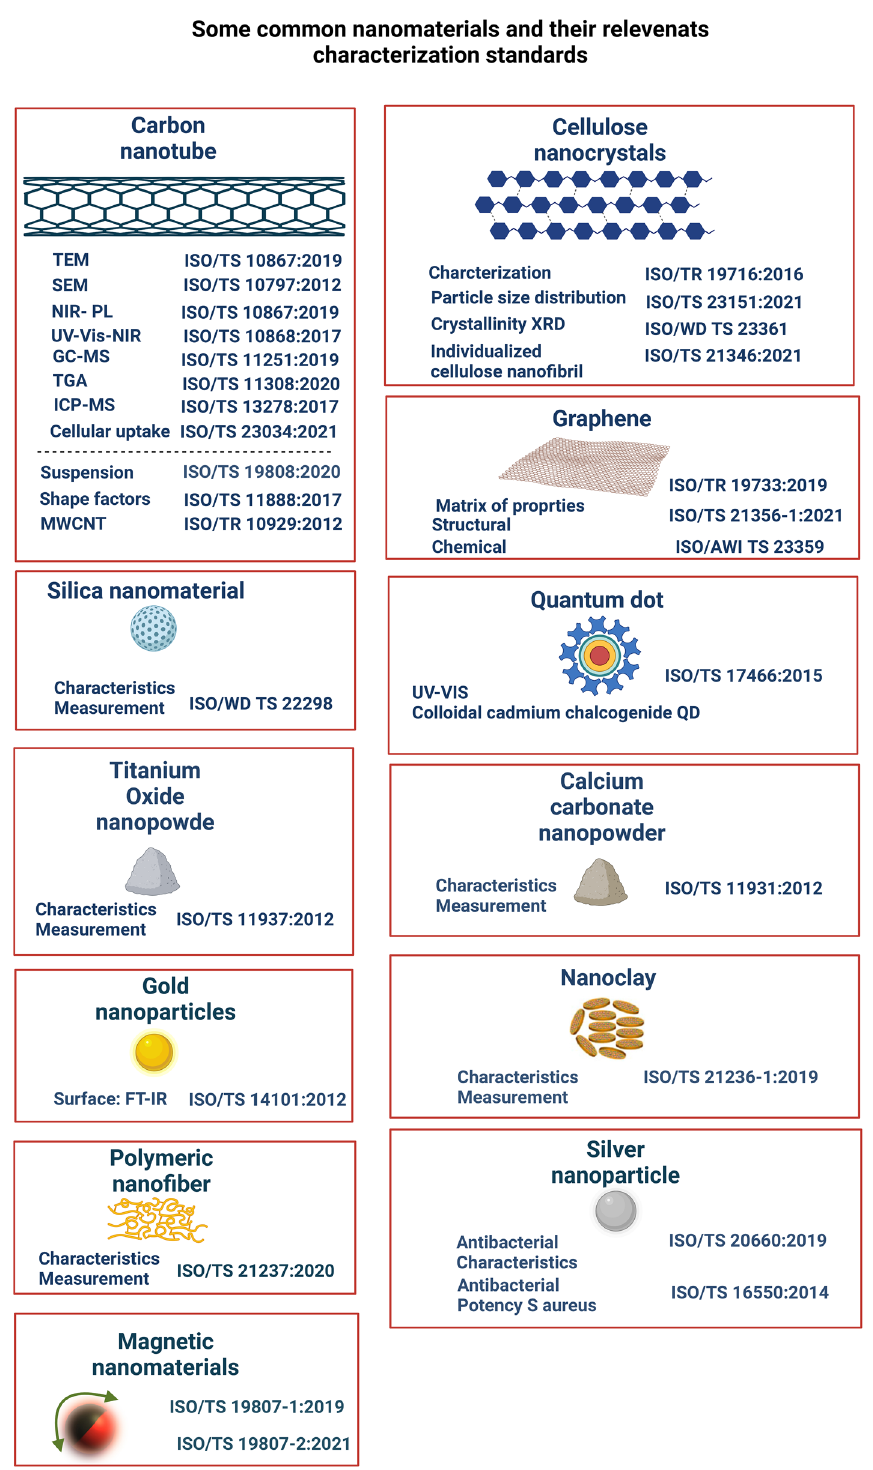
Fig. 2 Examples of available material-specific standards and characterization methodologies for different nanomaterials. Documentation on characterization methodologies for different nanomaterials is available based on ISO ID numbers and can help compile best practices for the analysis and characterization of different